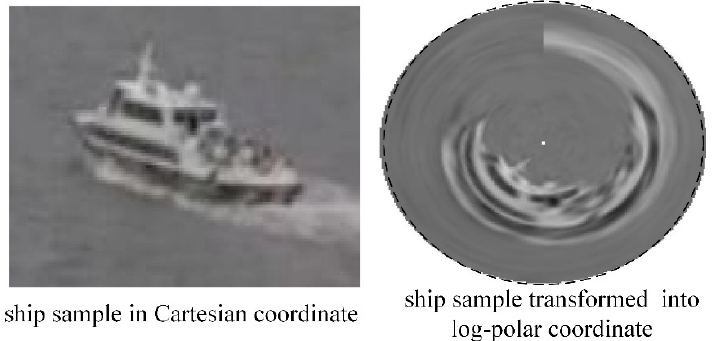
Figure 4. Ship sample mapping from Cartesian to log-polar coordinate.